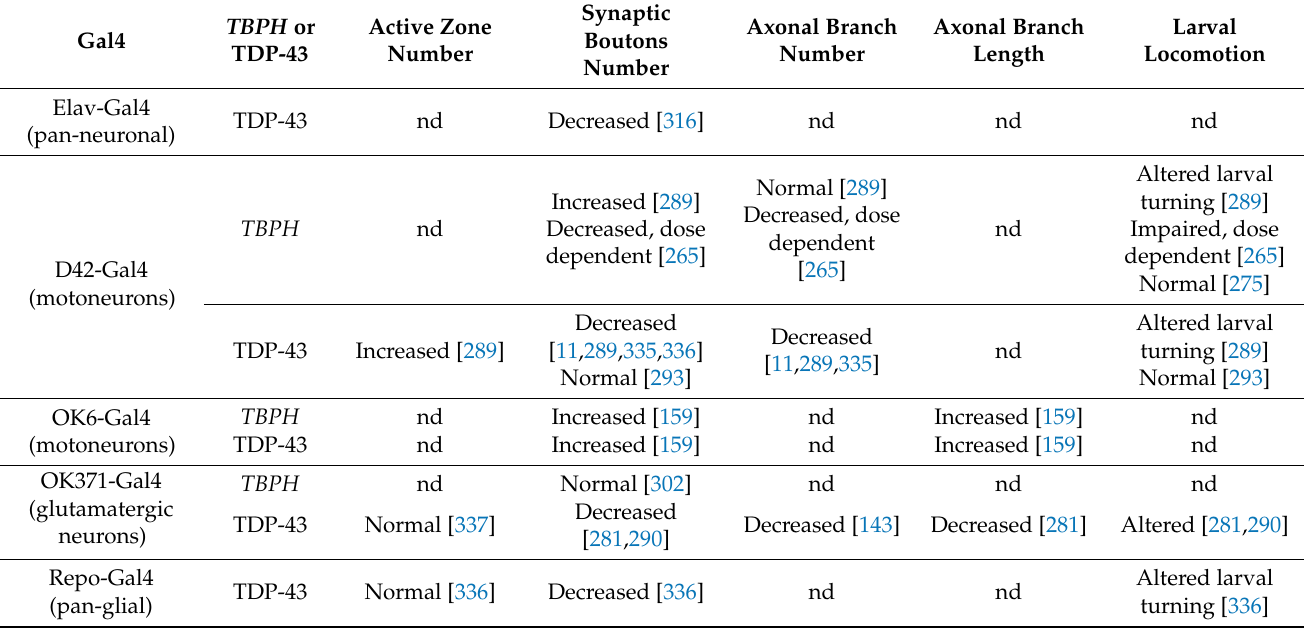
Table 11. Gain-of-function phenotypes induced by TBPH or TDP-43 at larval neuromuscular